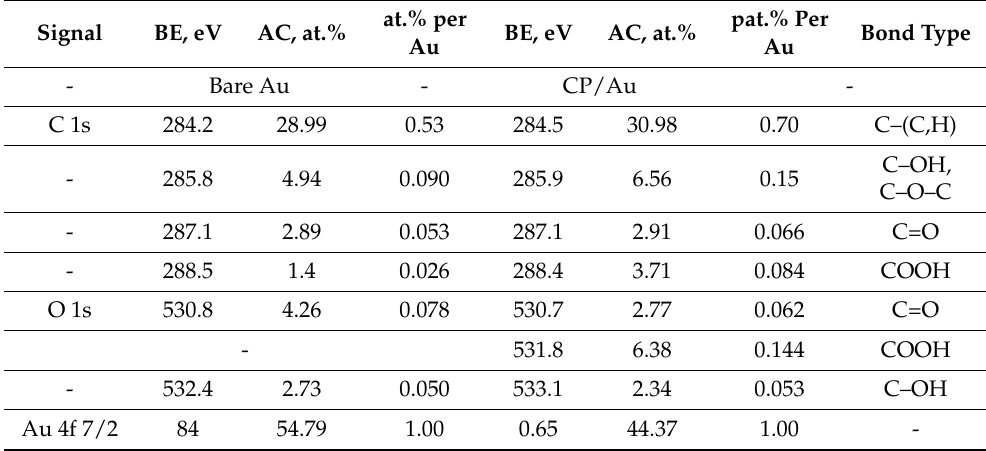
pat.% Per Bond Type Au